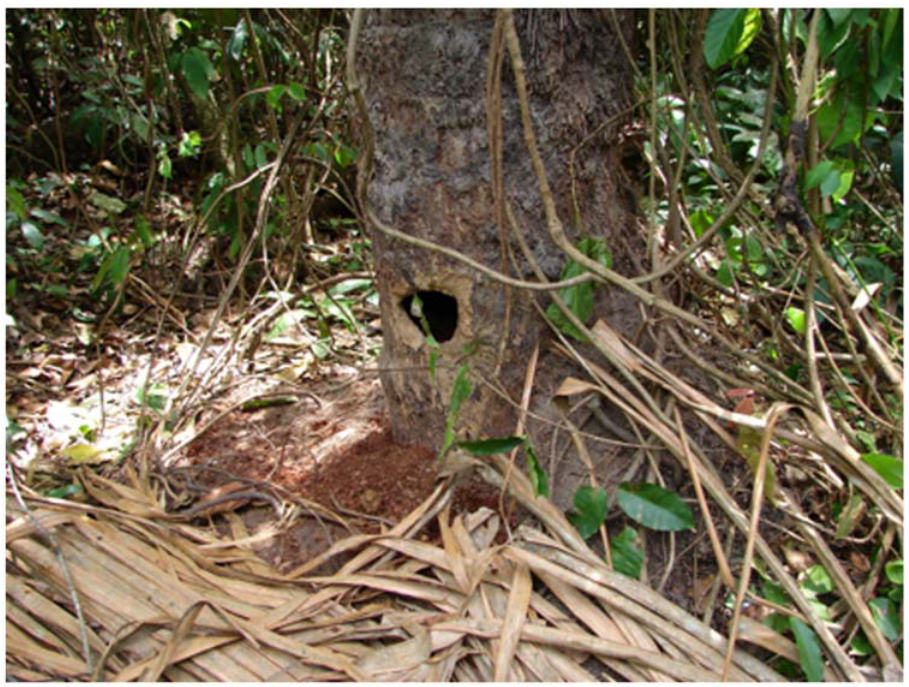
Figure 1. Decaying Raphia farinifera tree with medium sized hole.